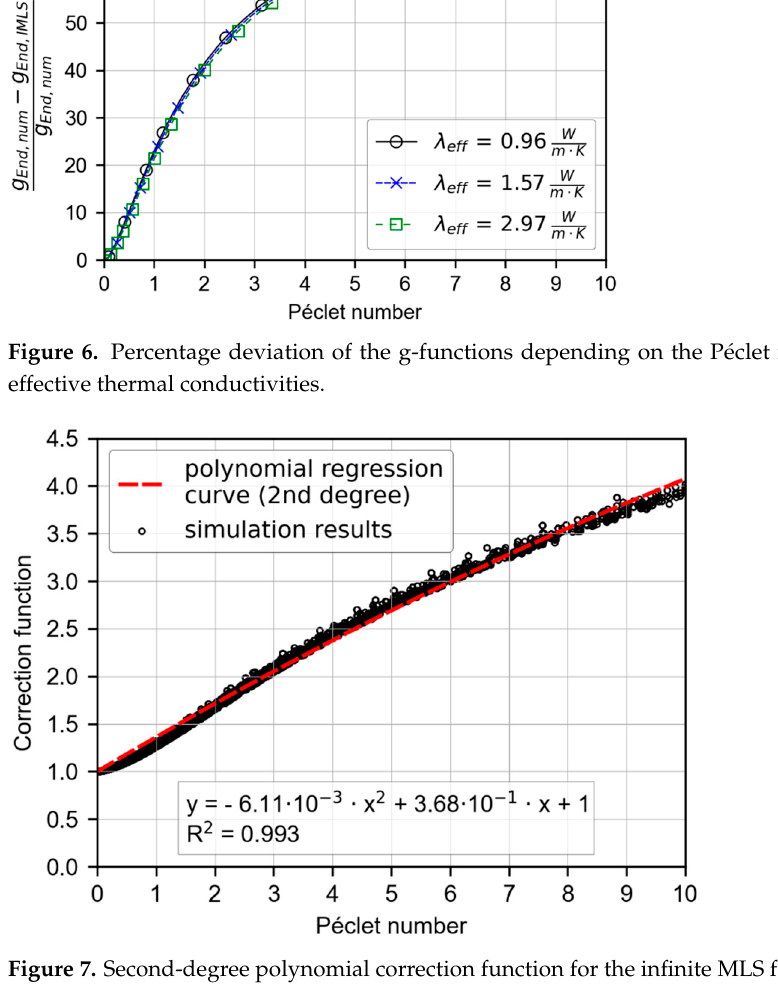
Figure 8. Groundwater g-function values for steady state conditions with and without correction. 3.5. Demonstration Example To demonstrate the impact of the proposed correction procedure for the design of a BHE, three examples for typical thermal and hydraulic property data for various geolog- ical materials as given by Sutton et al. [34] are investigated. These are listed in Table 3 as ‘Karst Limestone’, ‘Sand (Coarse)’, and ‘Gravel’. A fourth example, ‘Gravel (Modified)’, is also based on the same source but for an increased borehole radius of 0.075 m and a de- creased velocity leading to a Péclet number of 1. The Péclet numbers are calculated ac- cording to Equation (5), as by Sutton et al. [34].